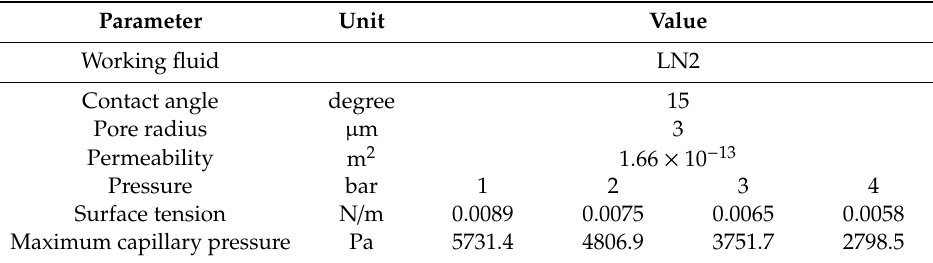
Table 1. Result of calculating the maximum generated capillary pressure of the wick.